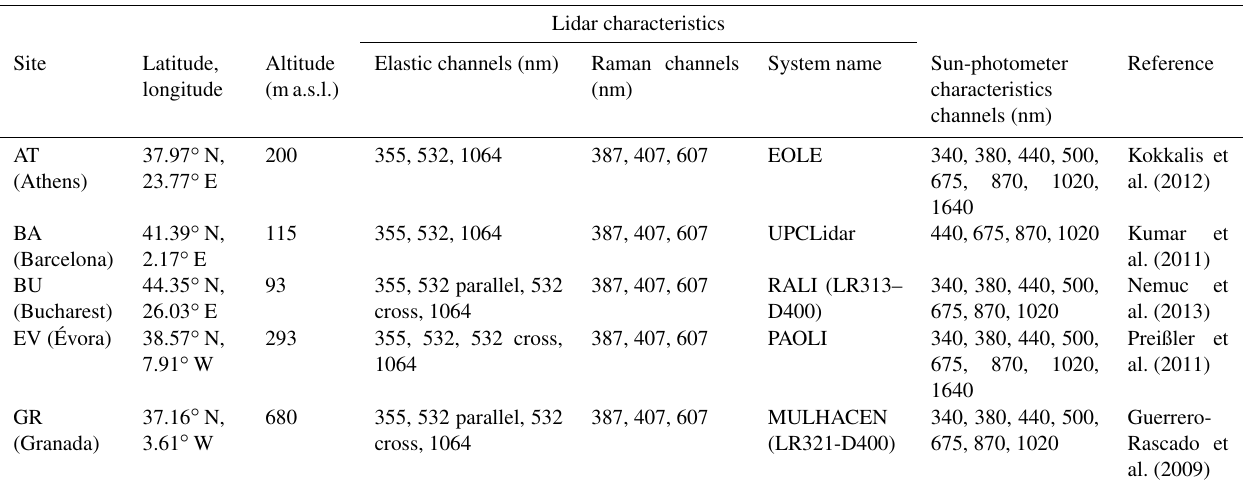
Table 1. Lidar and sun-photometer characteristics for the five stations considered in this study and depicted in Fig. 1. A more detailed description of the experimental sites and the lidar systems in every station can be found in the references included in the “Reference” column of the table.